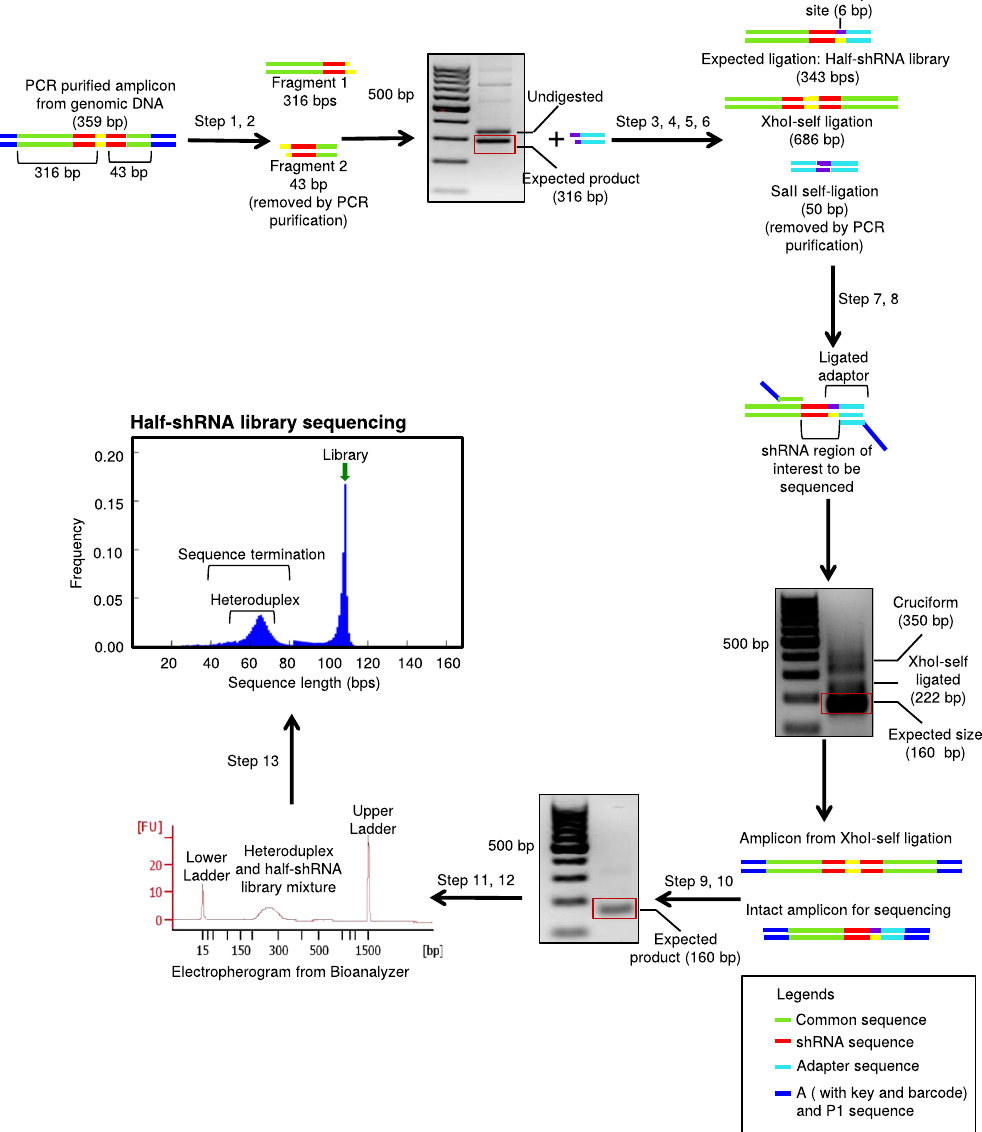
Figure 3. Elimination of the hairpin in shRNA library. Workflow showing steps to eliminate hairpin in the shRNA library. Step 1: XhoI digestion of purified PCR amplicon from gDNA. Step 2: PCR purification of XhoI- digested product. Step 3: Gel extraction of expected 316 bp XhoI- digested amplicon. Step 4: Preparation of the SalI adapter. Step 5: Adapter ligation to XhoI- digested amplicon. Step 6: PCR amplification of the ligated product. Step 7: PCR barcode labeling of the ligated product. Step 8: PCR amplification of the barcoded PCR product. Step 9: XhoI digestion of the amplicon from XhoI self-ligated product. Step 10: PCR amplification after digestion of amplicon from XhoI self-ligation. Step 11: Gel extraction of the 160 bp barcoded product. Step 12: Quality assessment of the barcoded product on the Bioanalyzer. Step 13: Half-shRNA library